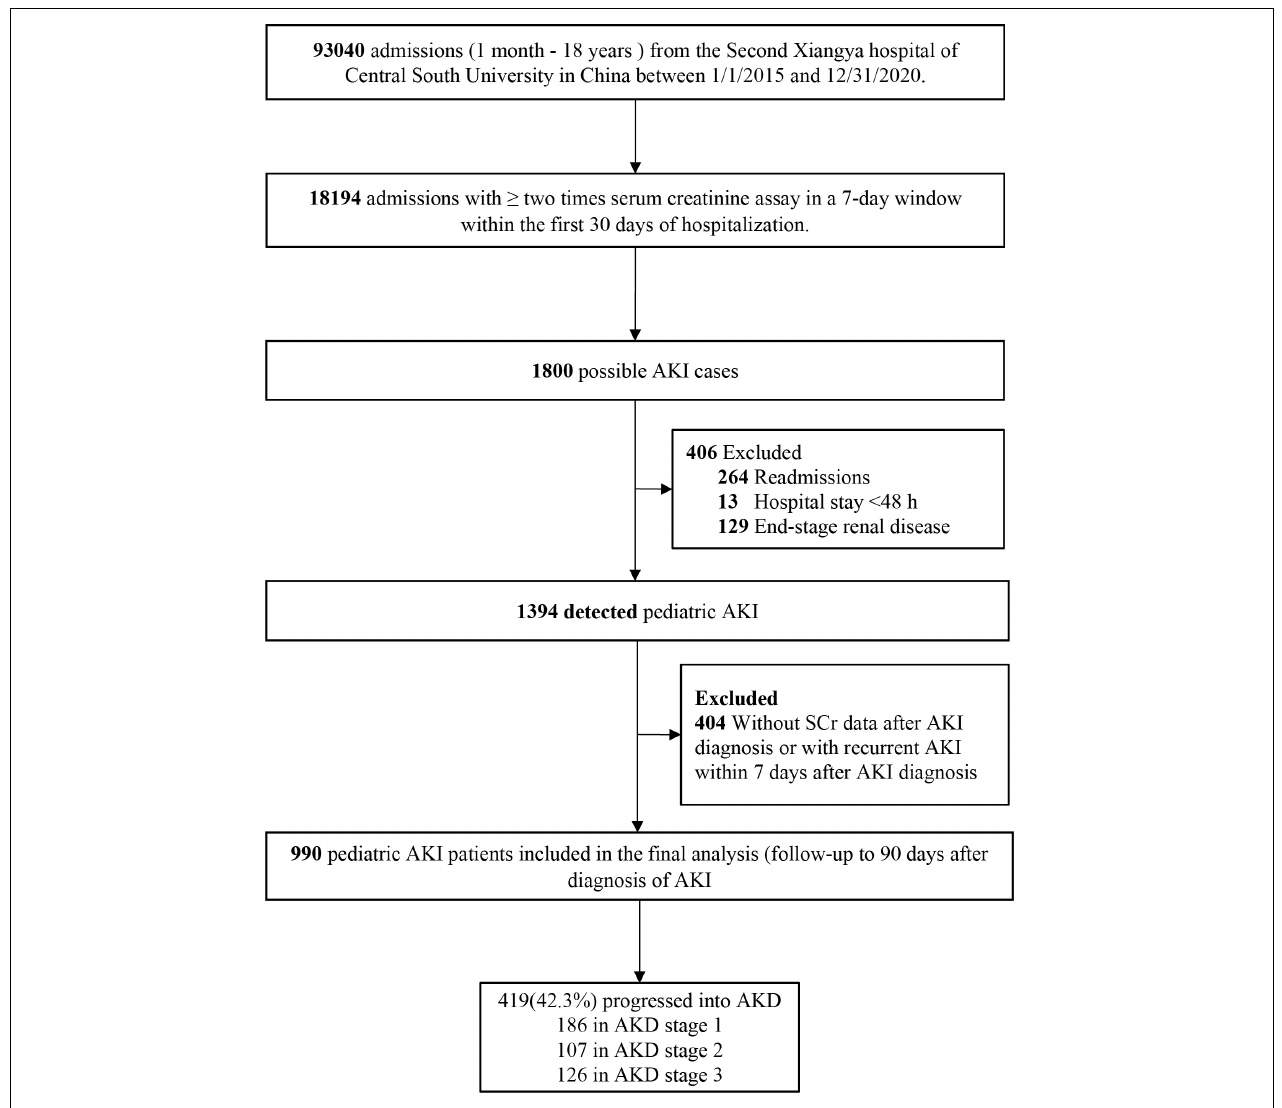
FIGURE 1 | Study flowchart. AKI, acute kidney injury; AKD, acute kidney